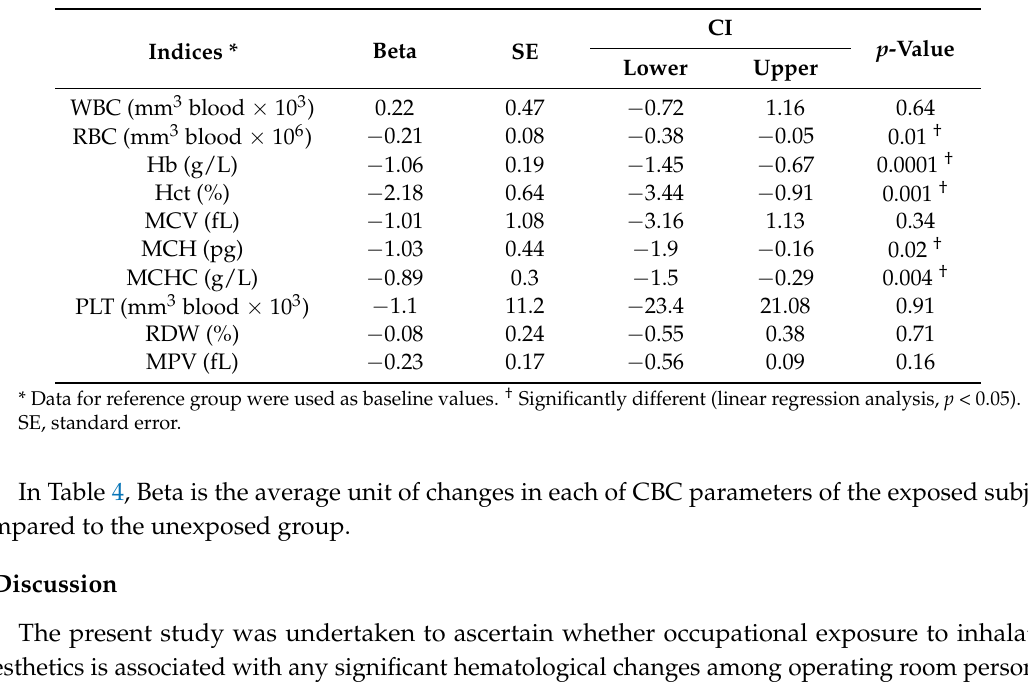
* independent sample t -test, p < 0.05.